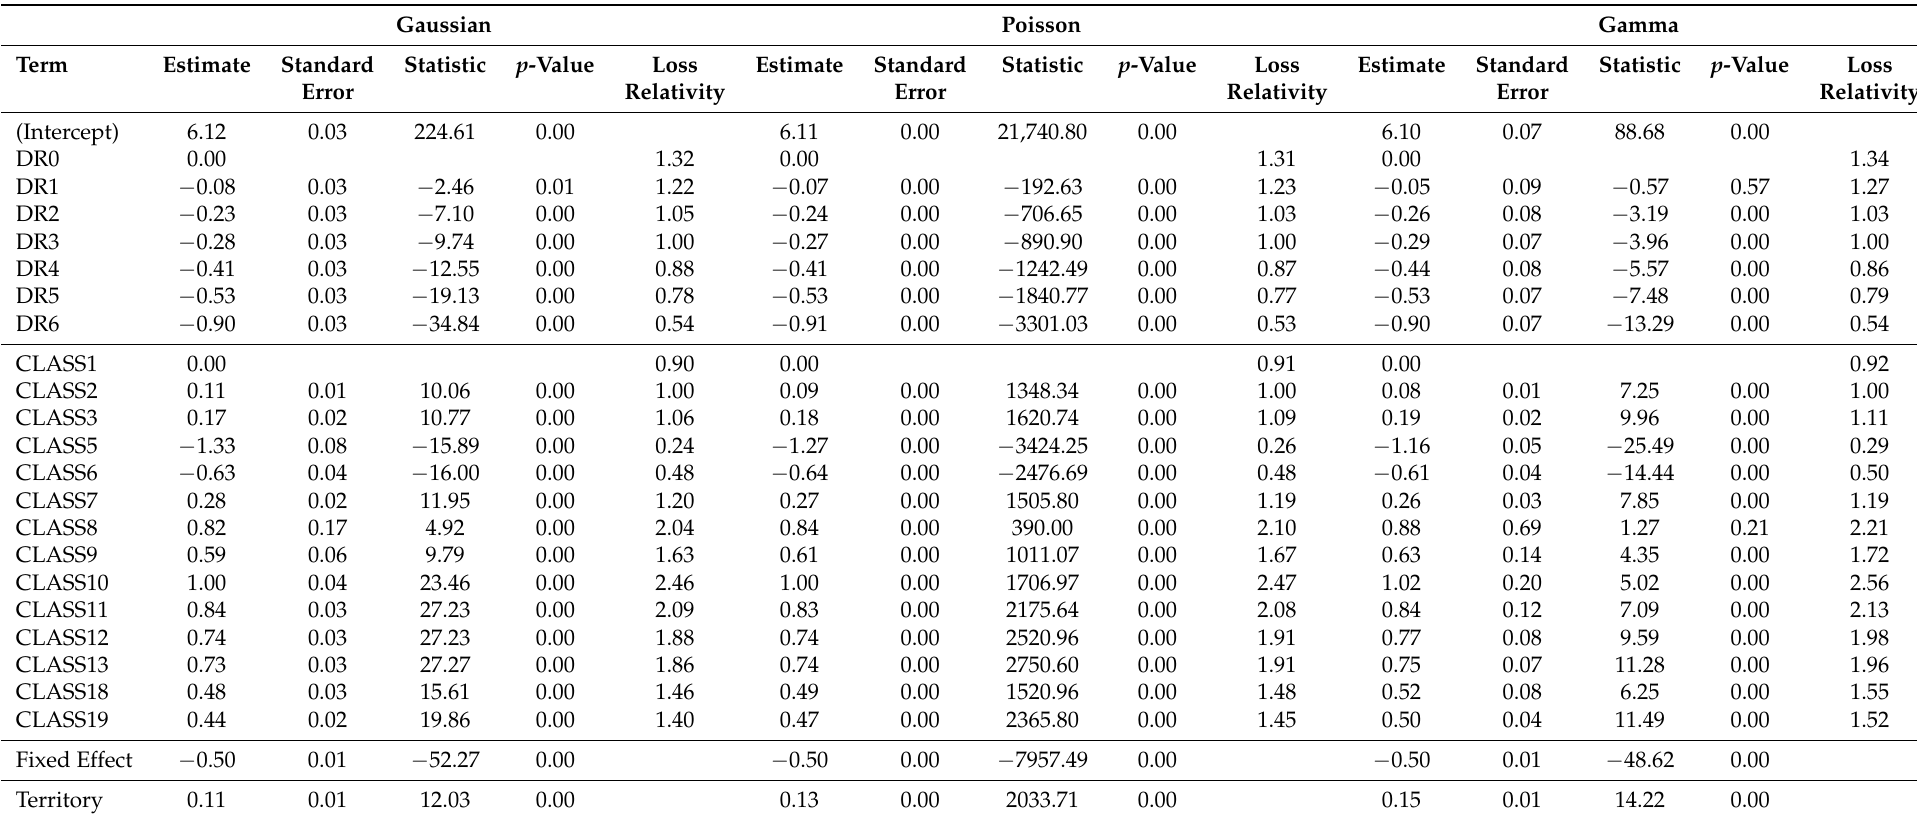
Table 5. Risk relativity estimates of DR and CLASS for COL coverage using the combined data of three accident years under the three-way model. Gaussian